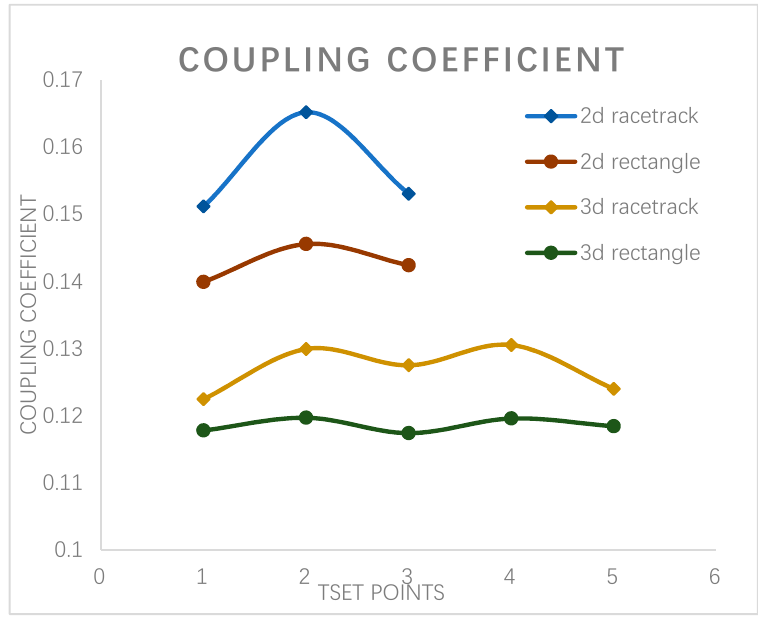
Figure 7. Coupling coefficient at different points.